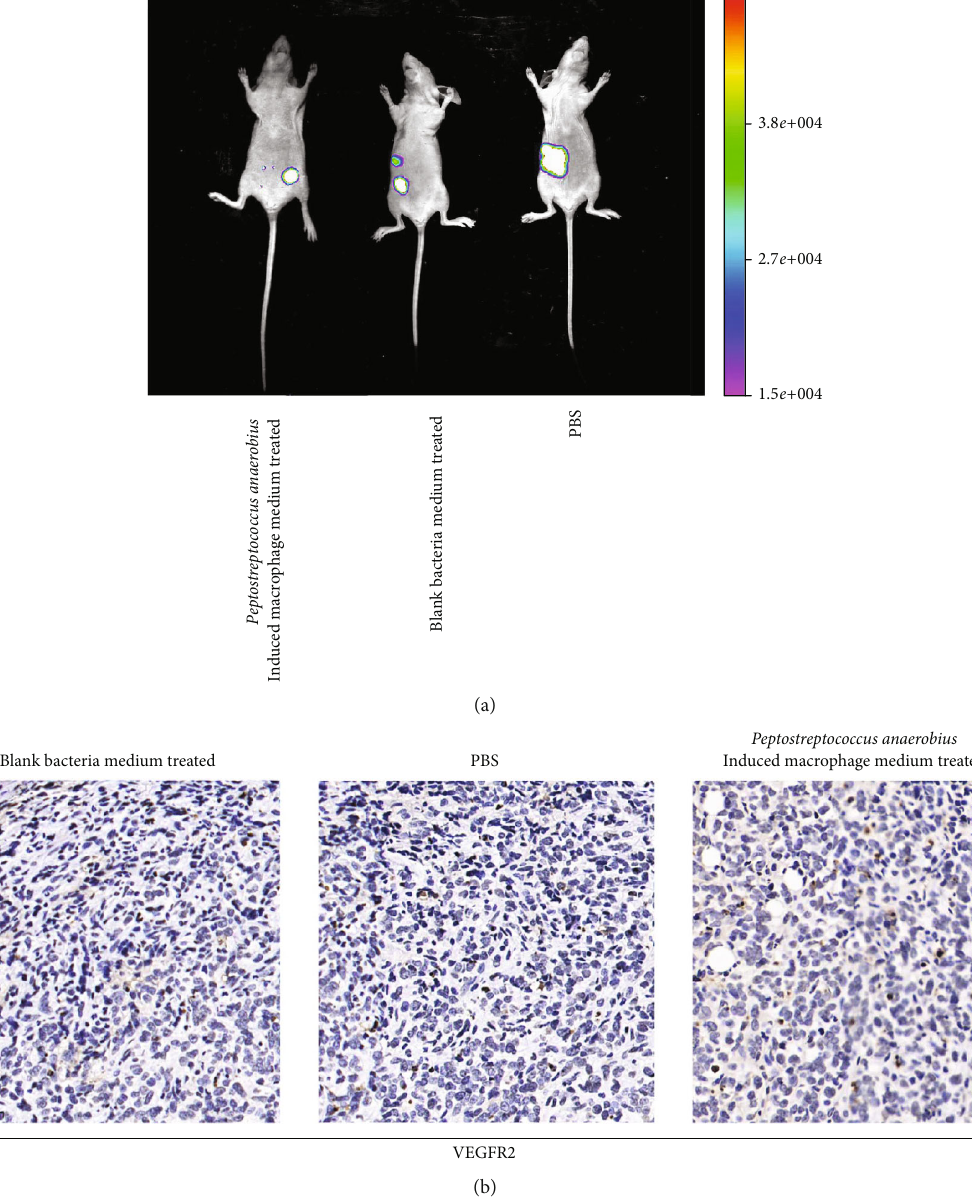
Figure 6: The e ff ect of VEGF from macrophages treated with Peptostreptococcus anaerobius on the migration in cervical cancer in vivo. (a) Bioluminescent images were visualized to evaluate the metastasis of cervical cancer cells after being treated with Peptostreptococcus anaerobius -induced macrophage-conditioned medium, blank bacteria medium-induced macrophage-conditioned medium, and PBS in the mouse model. Luminescence of cervical cancer cells was evaluated by an in vivo imaging system, in which the size of the luminescence area represents the metastasis ability. (b) The IHC staining for detecting the VEGFR expression in tumor after being treated with blank bacteria medium-induced macrophage-conditioned medium, PBS, and Peptostreptococcus anaerobius -induced macrophage-conditioned